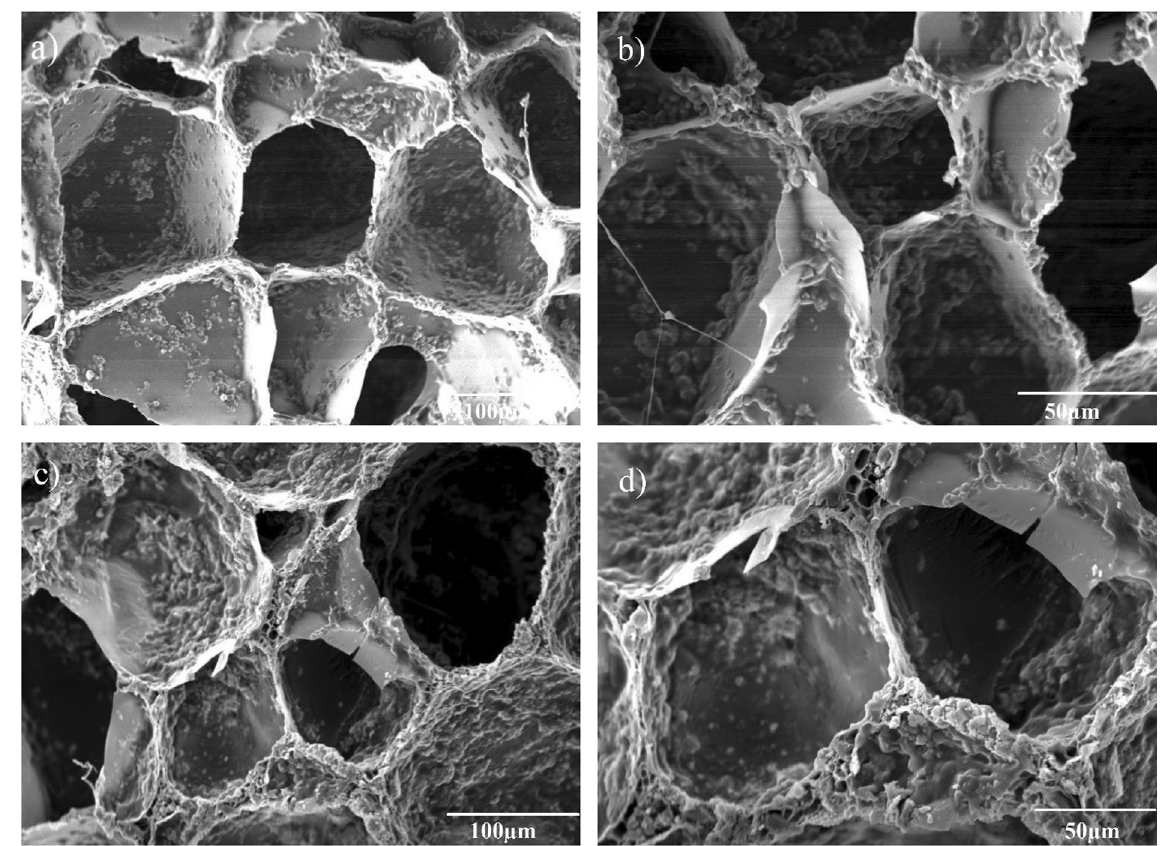
Figure 1. SEM images of the prepared scaffolds with different magnifications: Gel-BG ( a , b ), Gel-BG/Sr ( c , d